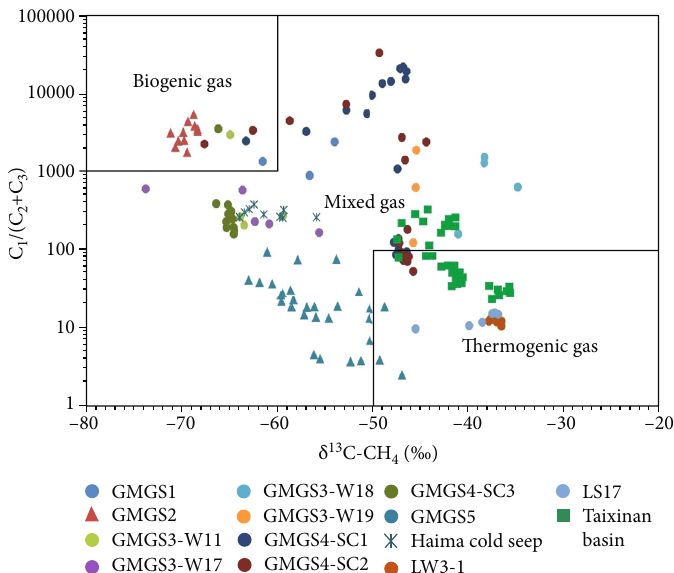
Figure 10: Genetic types of the hydrate gases associated with the cold seep system and conventional gas recovered from deep gas reservoirs in the Pearl River Mouth Basin (LW3-1) and the Qiongdongnan Basin (LS17) in the northern South China Sea. The GMGS 1, 2, 3, 4, and 5 hydrate gas data are from Su et al. [74], Zhang et al. [132], Zhang et al. [134], and Sha et al. [141]. The Haima Cold Seep hydrate gas data are from Minshull et al. [50]. The conventional gas data for LW3-1 and LS17 are from Dai et al. [131] and Zhang et al. [155]. The hydrocarbon data for the Taixinan Basin are from Chen et al.